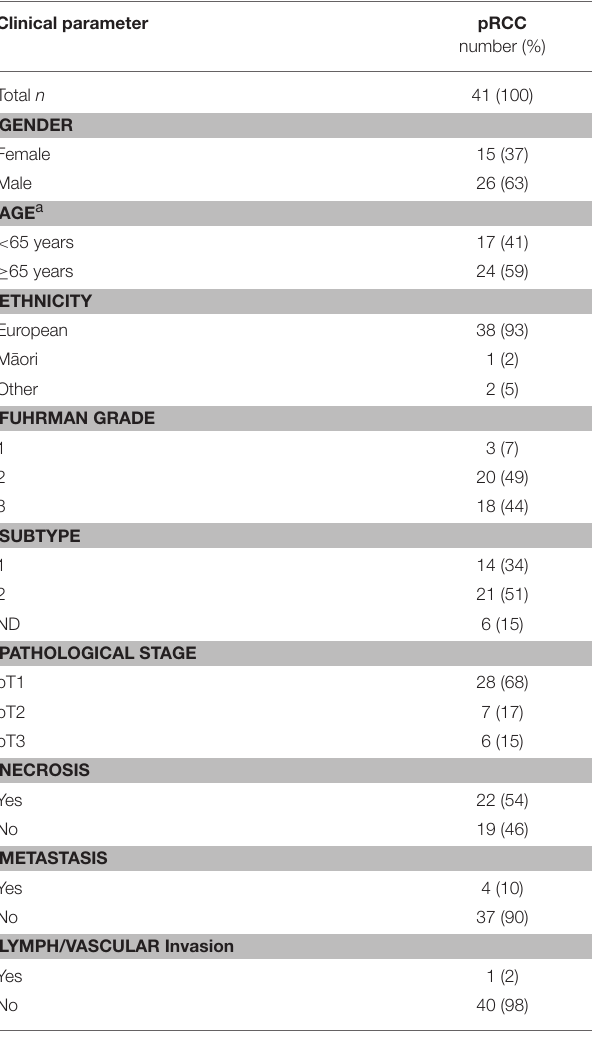
TABLE 1 | Patient demographics and tumor characteristics for papillary RCC. Clinical parameter